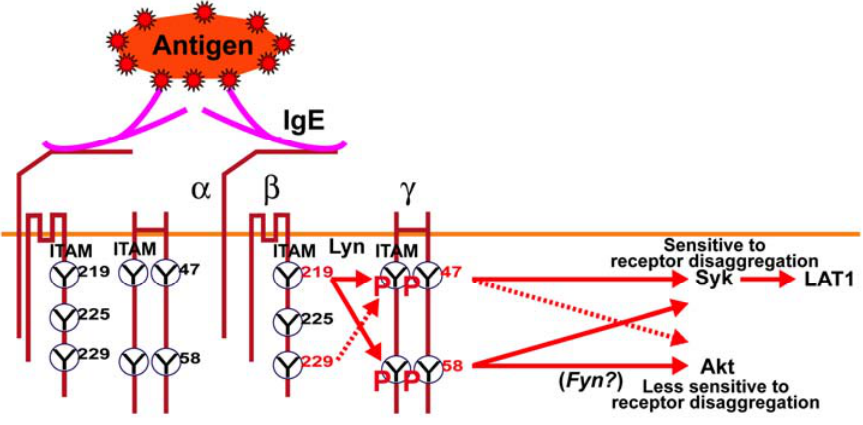
Figure 5. Schematic model of the regulatory role of Fc ε RI β and γ ITAM tyrosine’s on downstream signaling in mast cells. Ag-dependent aggregation of IgE antibody-occupied Fc ε RI on mast cells results in the Lyn kinase-dependent phosphorylation of the Fc ε RI β and γ ITAM tyrosine’s. The Fc ε RI β Y 219 is important for the full phosphorylation of Fc ε RI γ and was previously shown to be important for Lyn association with Fc ε RI [6]. Loss of phosphorylation at Fc ε RI γ Y 47 or Y 58 had a marked effect on Syk and LAT1 phosphorylation; molecules known to be important for mast cell degranulation. However, Akt phosphorylation (T 308 ), whose activity is required for cytoskeletal reorganization and gene expression, was largely unaffected by loss of phosphorylation at Fc ε RI γ Y 47 whereas loss of phosphorylation at Fc ε RI γ Y 58 greatly reducedAkt phosphorylation. This can be overcome by inhibition of tyrosine phosphatases, which fully restored Akt phosphorylation in Fc ε RI γ Y 58 F expressing mutant mast cells. Previous findings demonstrate that Fyn kinase is critical for Akt phosphorylation, thus we propose that Fc ε RI γ Y 58 is an upstream regulator of the Fyn-Gab2-Akt